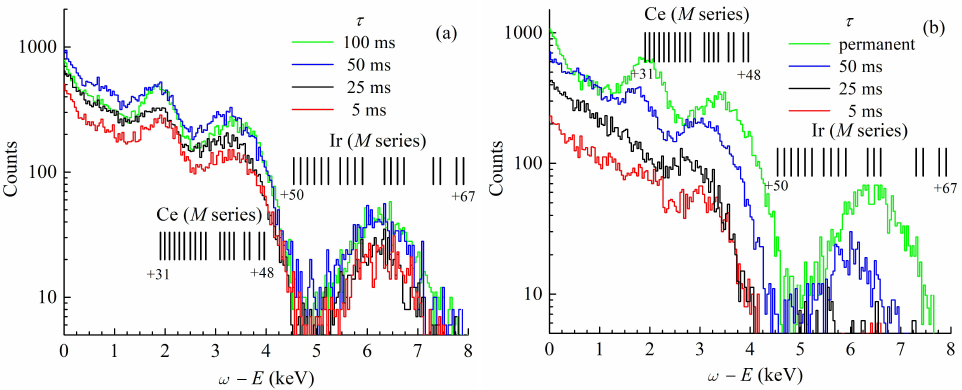
Figure 5. X-ray spectra of cathode materials for different durations of ion trapping. Energy E = 11.5 keV; current I = 20 mA; vacuum ∼ 7 × 10 − 9 mbar. Extraction voltage U ext : ( a ) 1.5 kV; and ( b ) 2.5